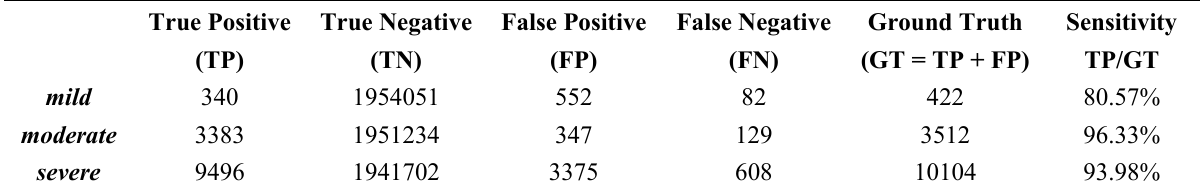
Table 2. Results for the binary discretely labeled MS lesion voxels (foreground) across the entire brain ROI of the mild, moderate and severe MS lesion brain data from BrainWeb.